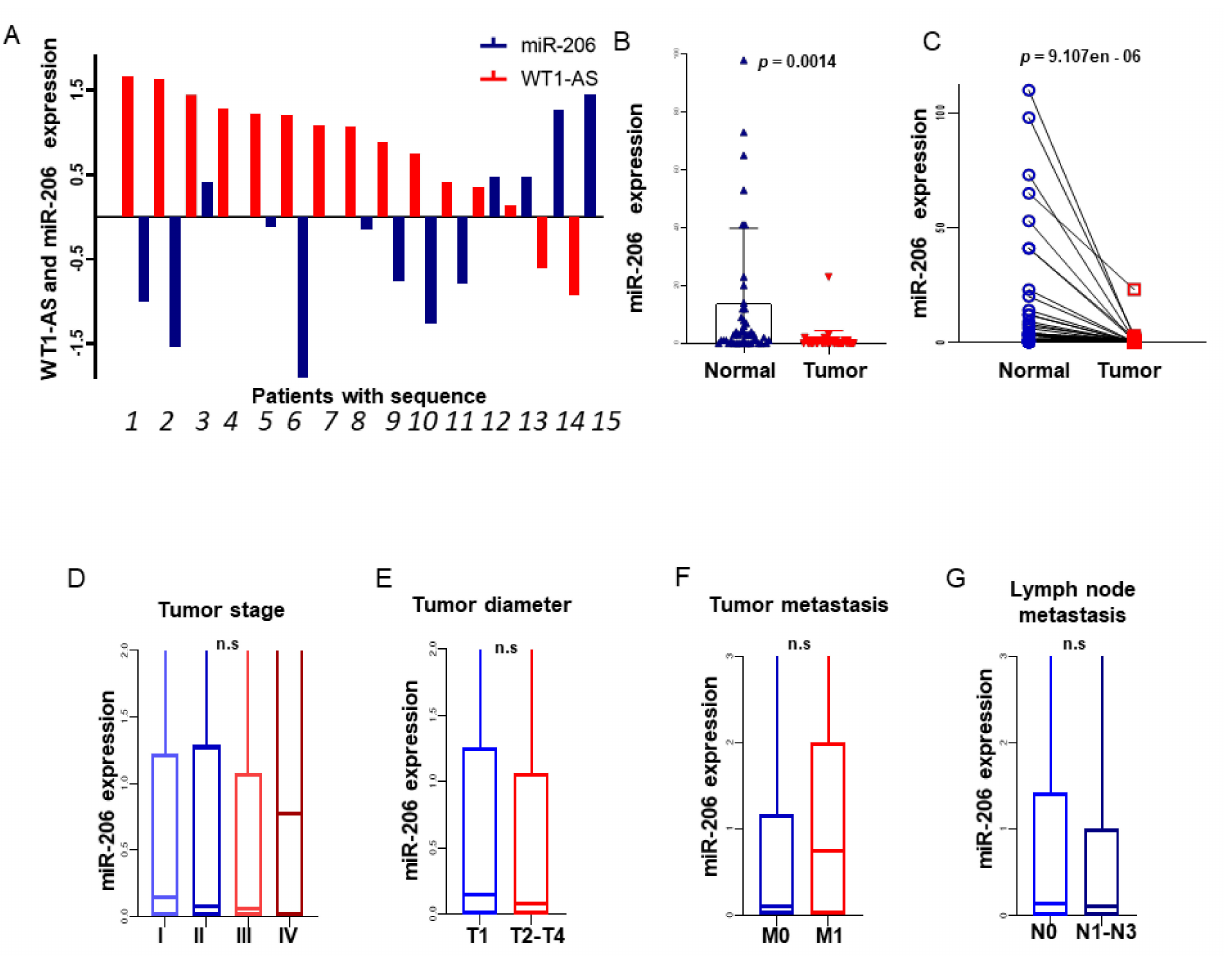
Figure 4. There was a negative correlation between the WT1-AS and miR-206 expression levels in the same patient ( A ). The expression level of miR-206 in tumor tissues and adjacent tissues of LUAD patients was significantly different ( B ). Paired difference analysis ( C ). The relationship between miR-206 and LUAD stage, tumor diameter, tumor metastasis, and lymph node metastasis ( D – G